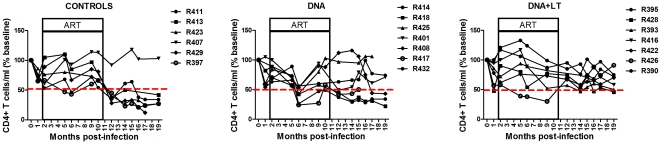
Therapeutic DNA vaccination protects from AIDS.Maintenance of CD4+ T cell counts as a marker of clinical disease progression was measured by flow cytometry. Shown is % CD4+ T cell count relative to baseline. Animals that maintained their CD4+ T cell counts above 50% of their baseline level (hashed line) level remained clinically healthy throughout the study.